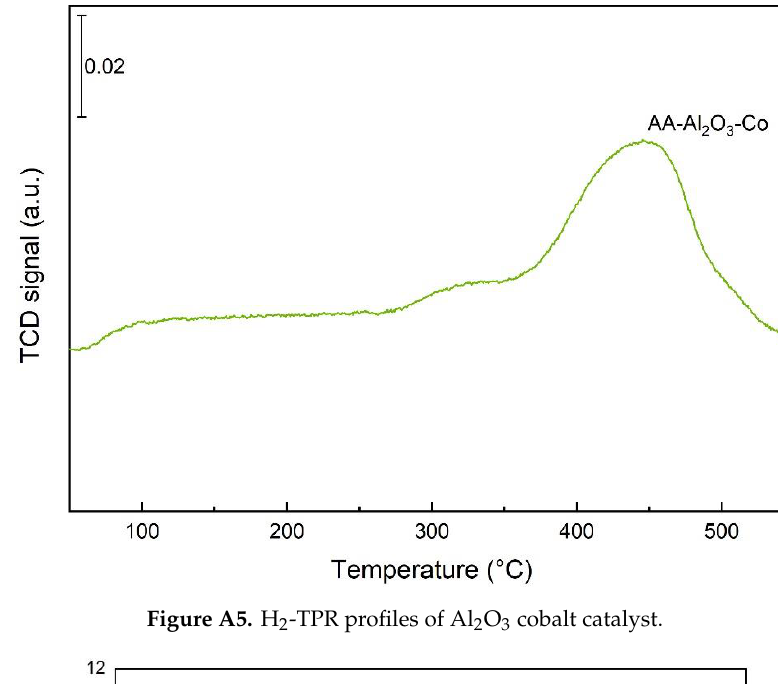
Figure A5. H 2 -TPR profiles of Al 2 O 3 cobalt catalyst.